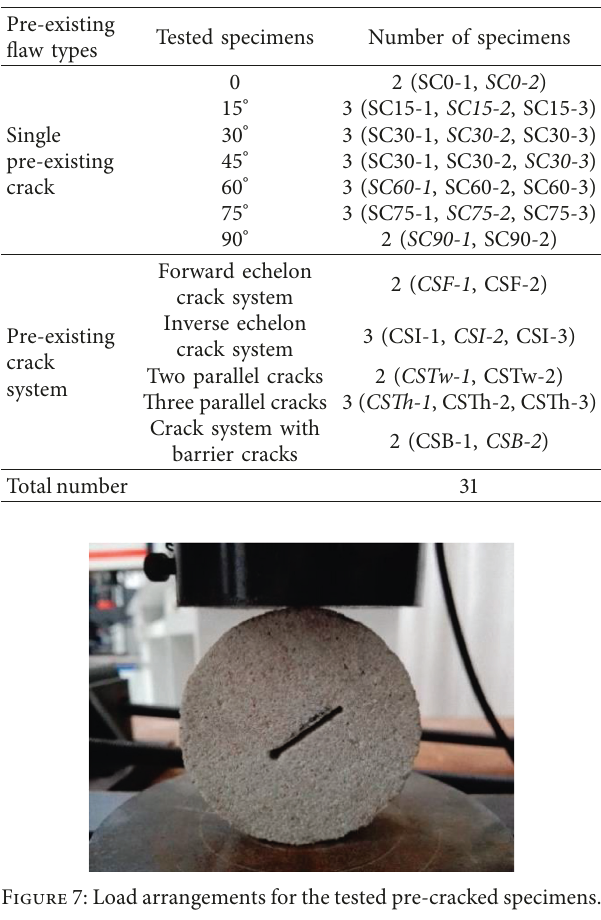
Table 1: Specimens containing different types of pre-existing flaws.